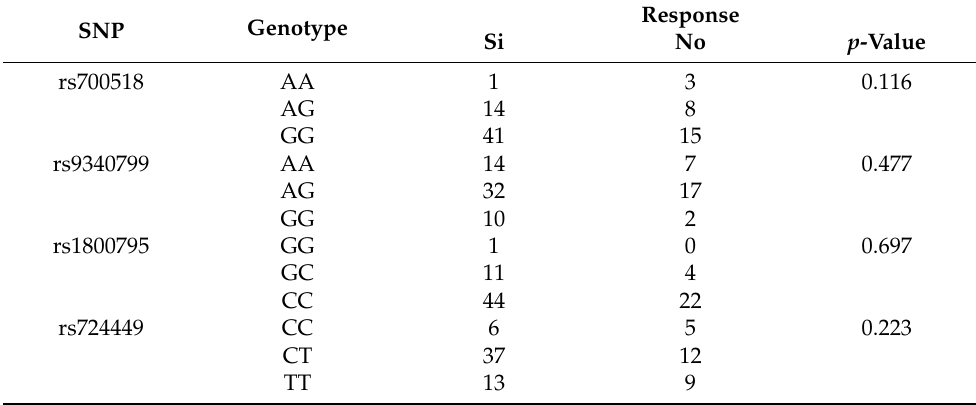
Table 3. SNP association between response to alendronate